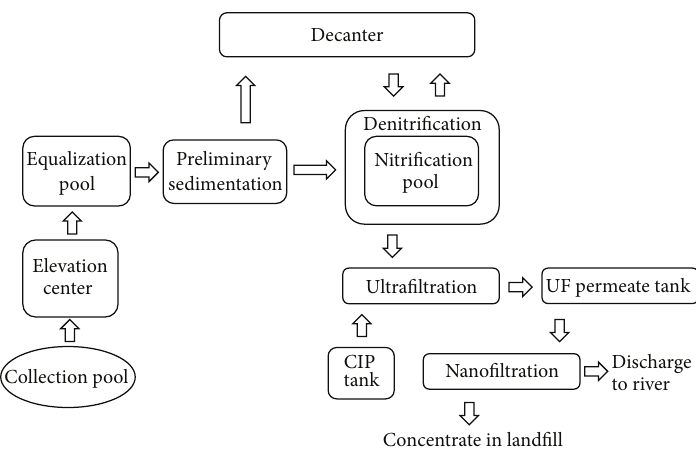
Figure 1: Komurcuoda leachate treatment plant flow